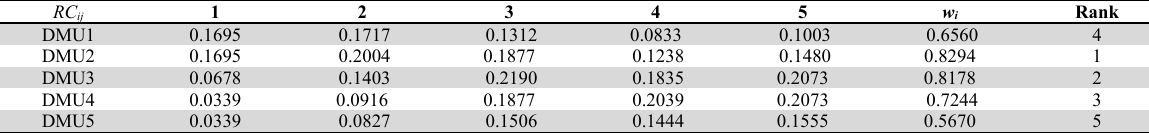
The rating and ranking of proposed method for performance assessment problem RC ij 1